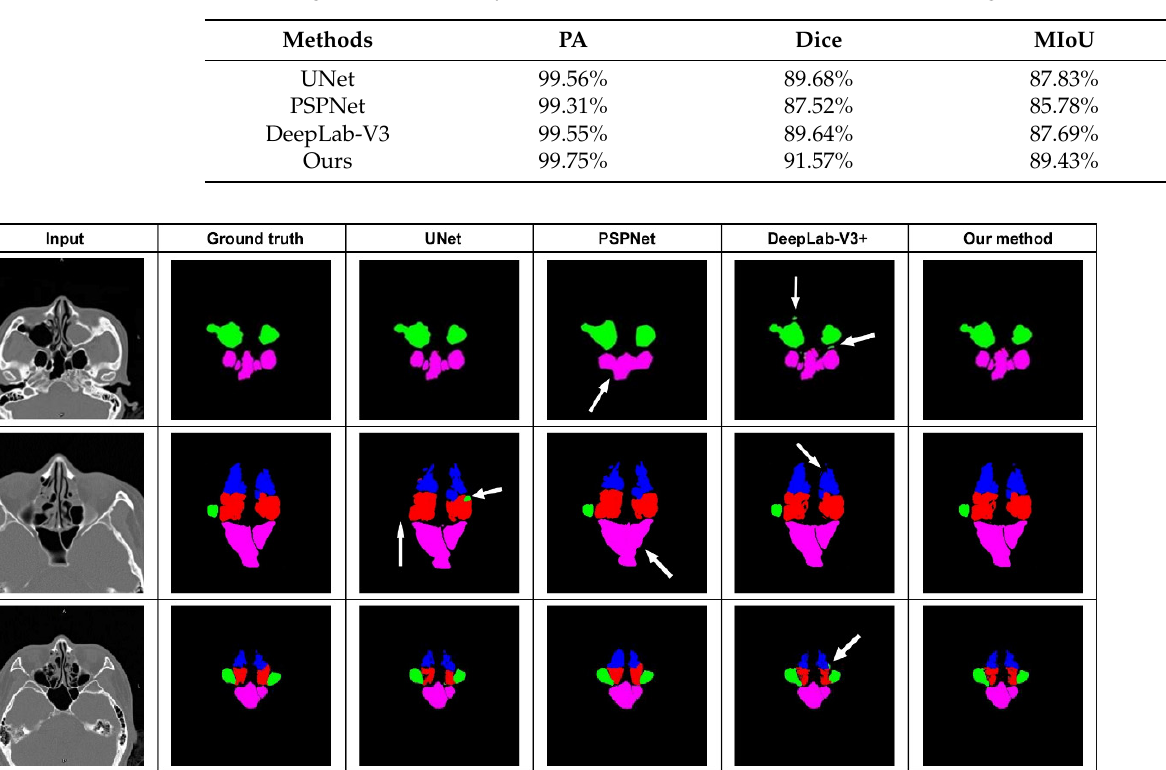
Figure 1. Segmentation results from comparison between our proposed method and other state-of-the-art networks. U-net misjudged part of the ethmoid sinus as the maxillary sinus. PSPnet had the least fine detailed information. Deeplab-V3+ showed inadequate accuracy in sinus boundary inter- pretation. Table 2. Segmentation accuracy of sinus between three observers and automatic segmentation methods.